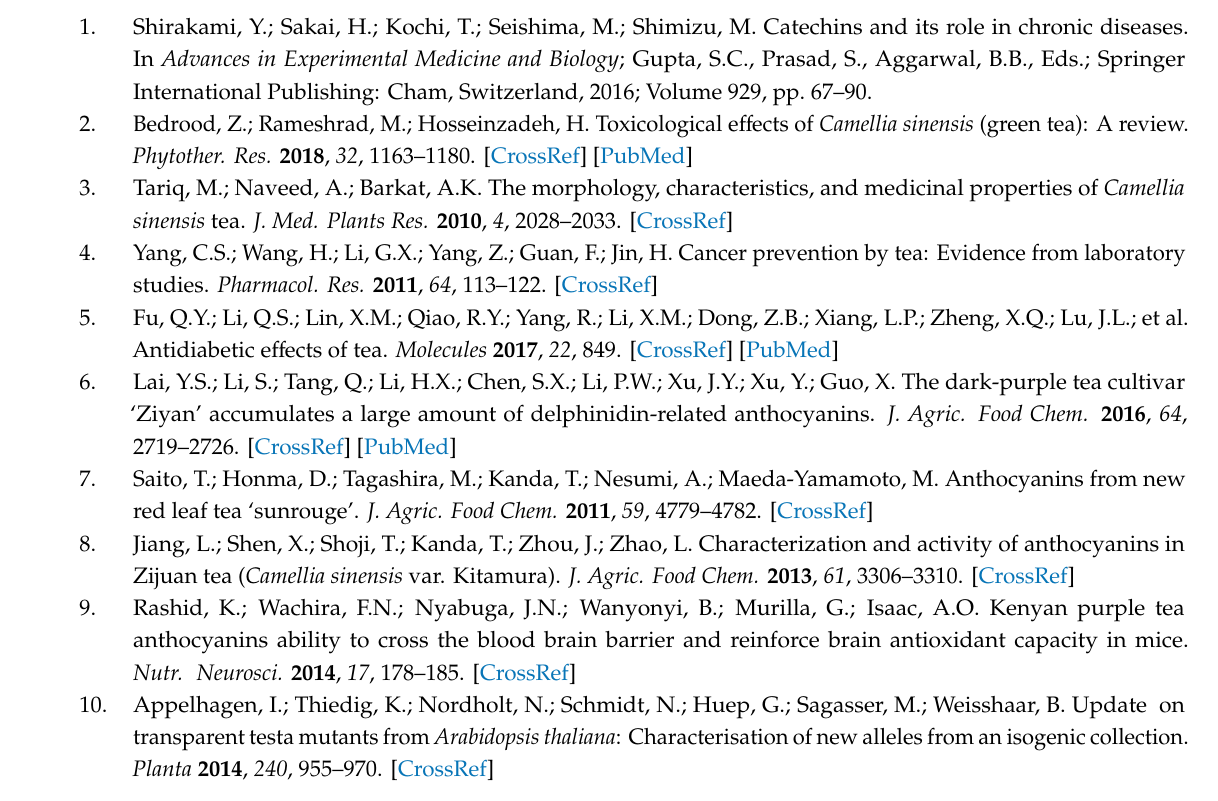
Supplementary Materials: Supplementary Materials are available online, Table S1: Summary of functional annotations for DEGs. Table S2: GO analysis of DEGs in W vs. UV-A. Table S3: GO analysis of DEGs in W vs. UV-B. Table S4: GO analysis of DEGs in W vs. UV-AB. Table S5: KEGG enrichment analysis of DEGs in W vs. UV-A. Table S6: KEGG enrichment analysis of DEGs in W vs. UV-B. Table S7: KEGG enrichment analysis of DEGs in W vs. UV-AB. Table S8: Transcription data for transcription factors (TFs) under di ff erent treatments. Table S9: Expression patterns of genes involved in chlorophyll metabolism. Table S10: List of primers used for qRT-PCR analysis. Figure S1: qRT-PCR validation of selected genes. The left y-axis shows the relative gene expression levels, and the right y-axis indicates the corresponding expression levels in RNA-Seq data. Data are represented as means ± standard